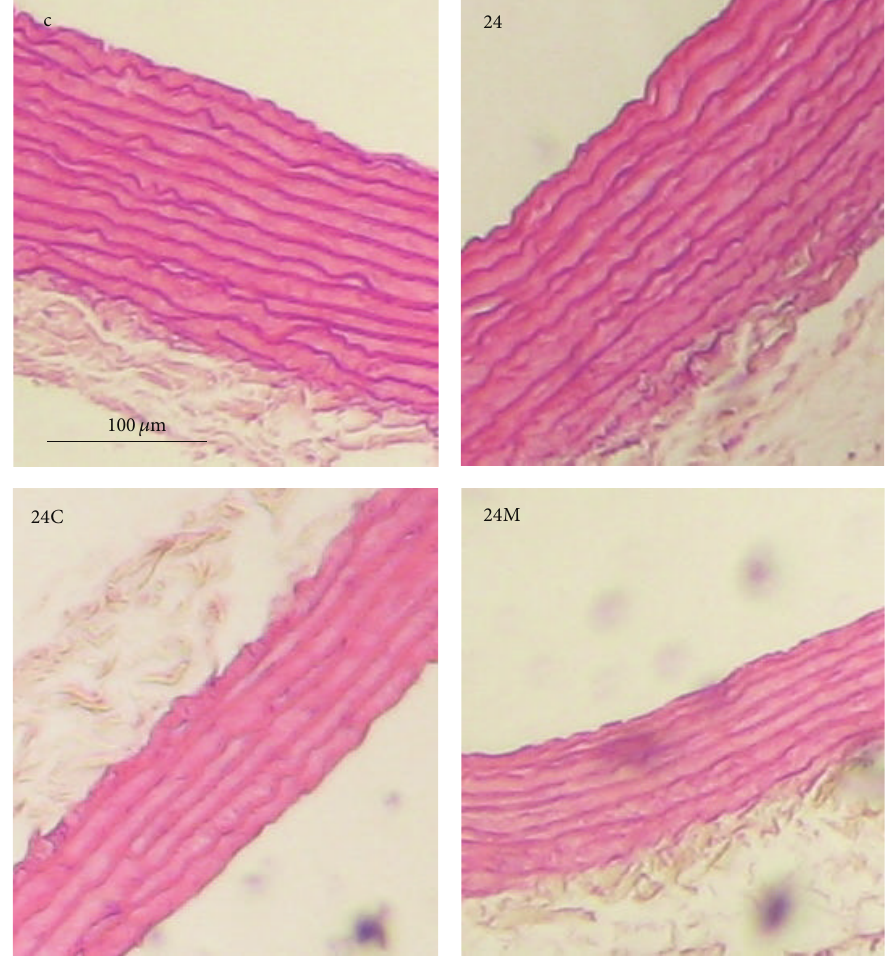
Figure 5: The influence of captopril (24C) and melatonin (24M) on wall thickness of aorta stained by hematoxylin-eosin in 24 hours/day continuous light exposure-induced hypertension (24). c: Wistar